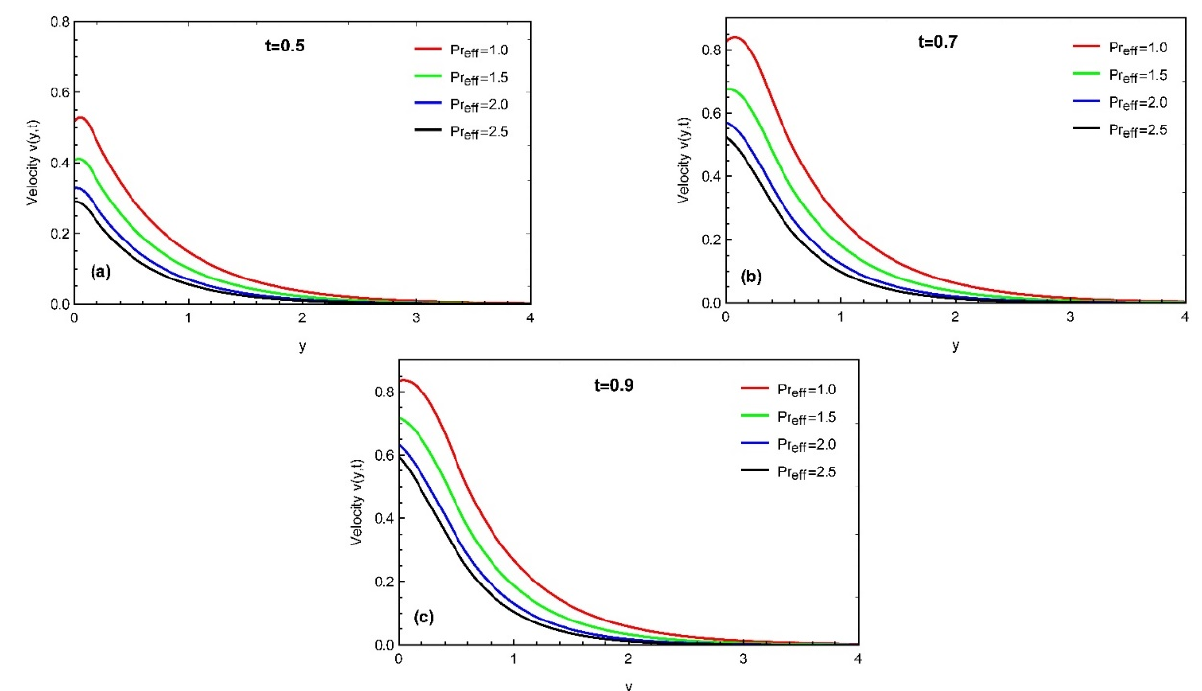
Figure 7. Variation in momentum field due to effective Prandtl number with α = β = γ = 0.7, Sc ef f = 1.1, M = 1.75, Gr = 0.75, Gm = 0.5, Re = 1.3, θ 1 = θ 2 = π 0.5 ( b ) t = 0.7 ( c ) t = 0.9.